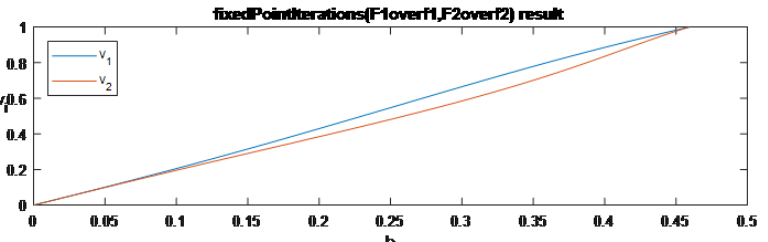
Fig. 1 Fixed point iterations result of the ratios of the two bidders’ valuations CDF/PDF functions